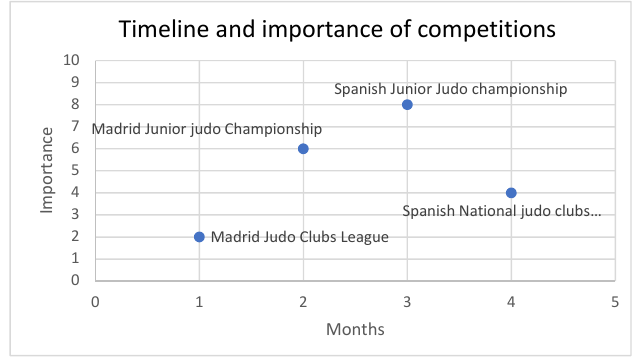
Figure 1. Timeline and importance of competitions during the season.